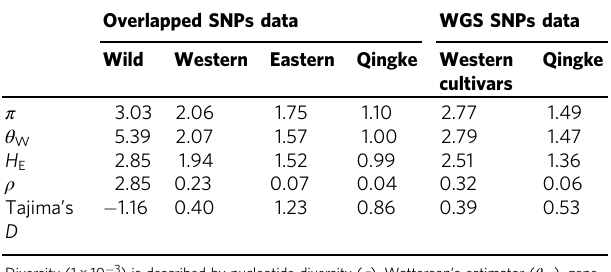
Table 1 Genetic diversity and Tajima ’ s D in barley groups Overlapped SNPs data